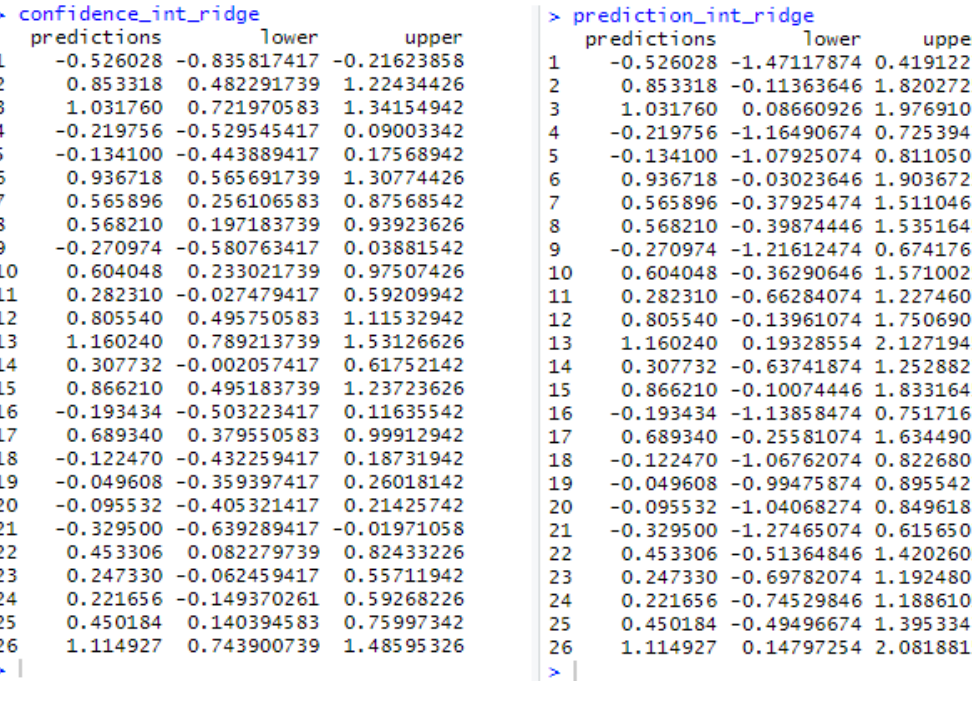
Figure 5. Confidence and prediction intervals for ridge regression predicted